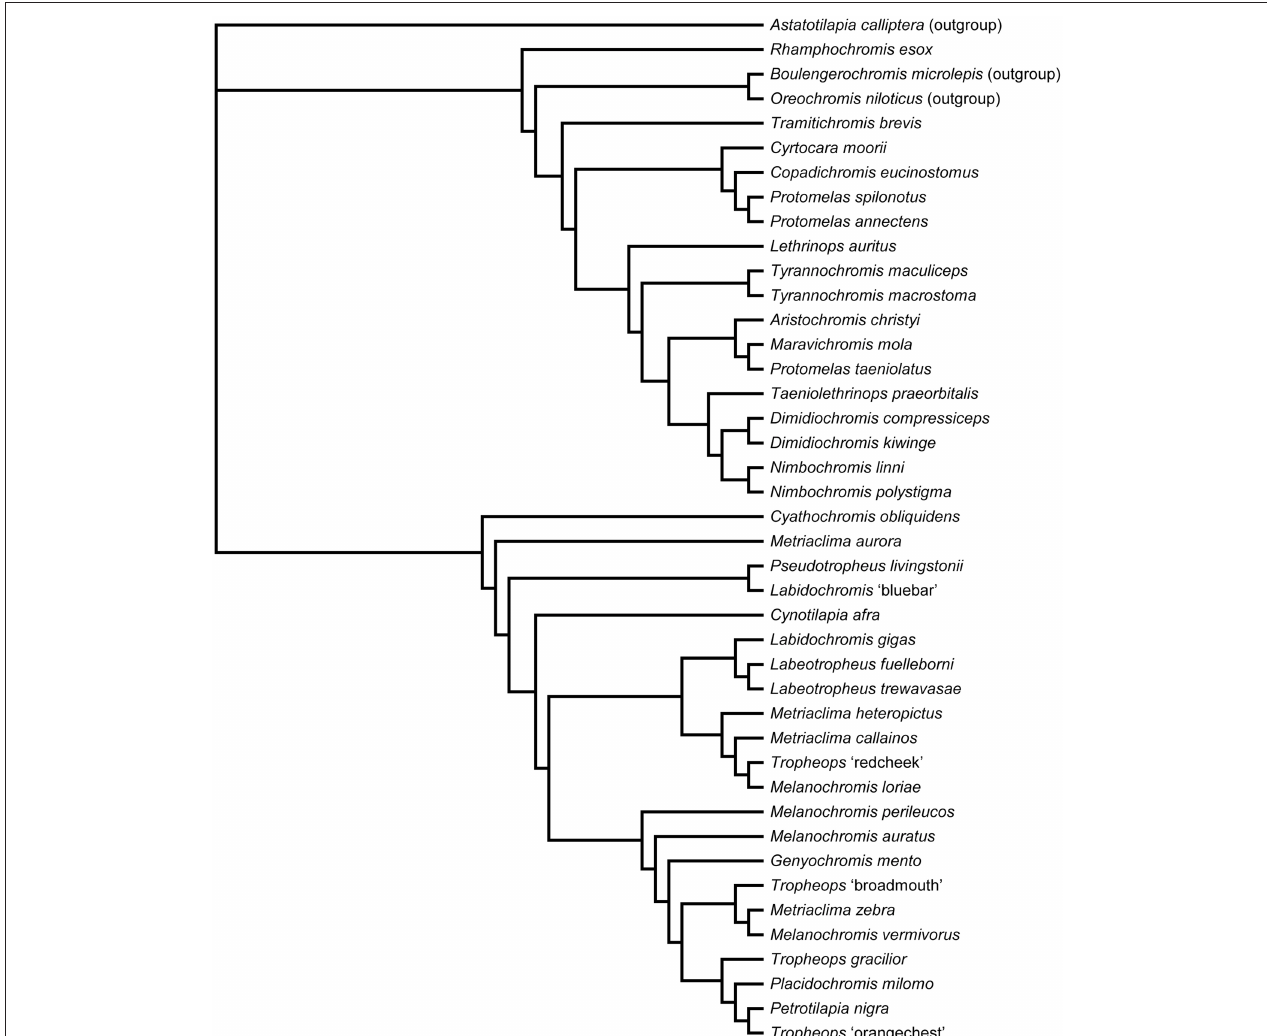
FIGURE 1 | Maximum Likelihood phylogeny of Lake Malawi cichlids based on the ND2 mitochondrial